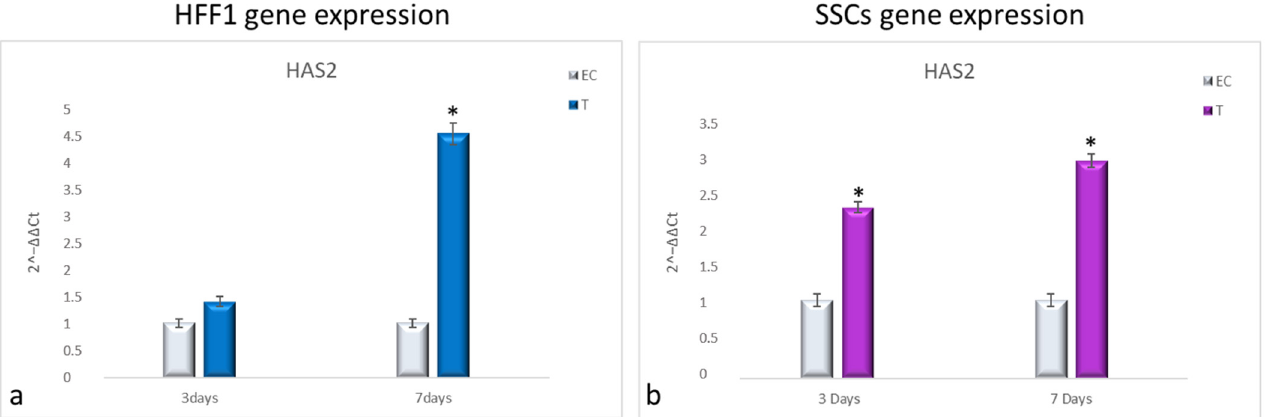
Figure 6. Gene expression analysis of HAS2 in HFF1 ( a ) and SSCs ( b ). HFF1 and SSCs were exposed to the different culturing conditions. mRNA levels of HAS2 in EC-HFF1 ( a , grey bars) and T-HFF1 (blue bars). mRNA levels of HAS2 in EC-SSCs ( a , grey bars) and T-SSCs (purple bars). mRNA levels are expressed as fold change (2 − ∆∆ ct ) compared with negative controls (UnC = 1). EC and T cells were exposed to UV light for 2 min at 10 cm distance from the lamp to induce oxidative stress. UnC samples were not exposed to UV light and not pre-treated with NanoPCL-M (UnC = 1). T samples were pre-treated with NanoPCL-M before UV stress exposure. * p ≤ 0.05.